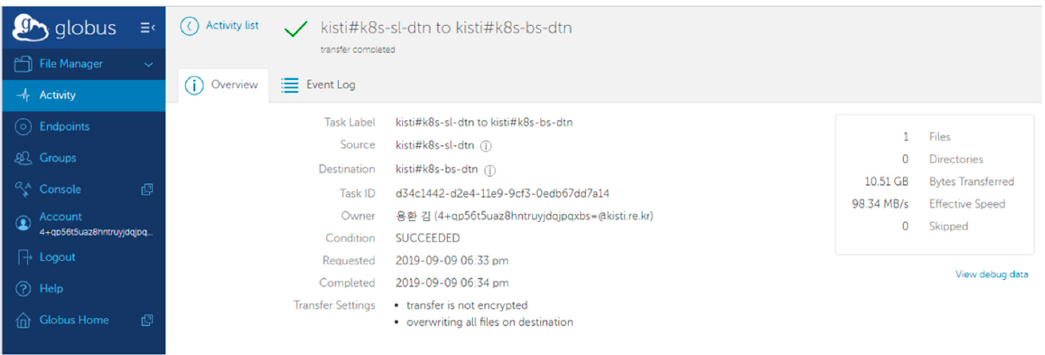
Figure 7. Large file transfer experiments based on virtual network slice and Globus Online (Korean characters in this figure indicates the name of the experimenter).